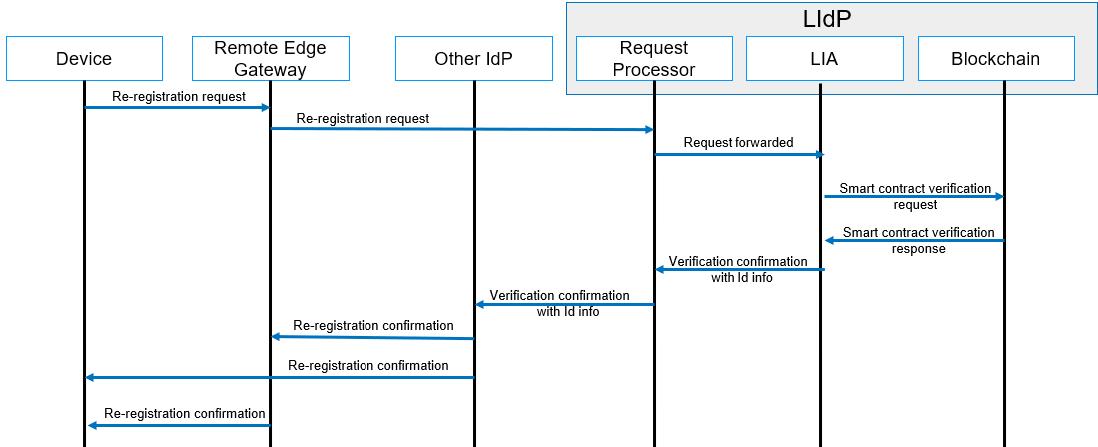
Figure 10. Re-registration process message flow.